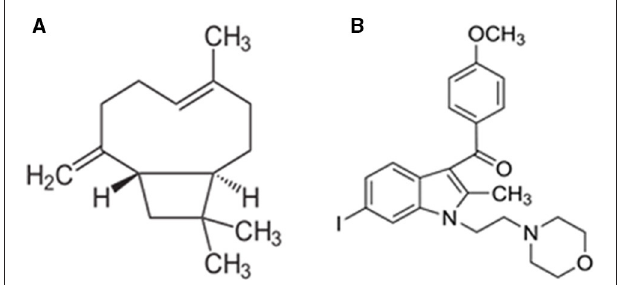
FIGURE 1 | Chemical structure of β -caryophyllene (A) and AM630 (B).